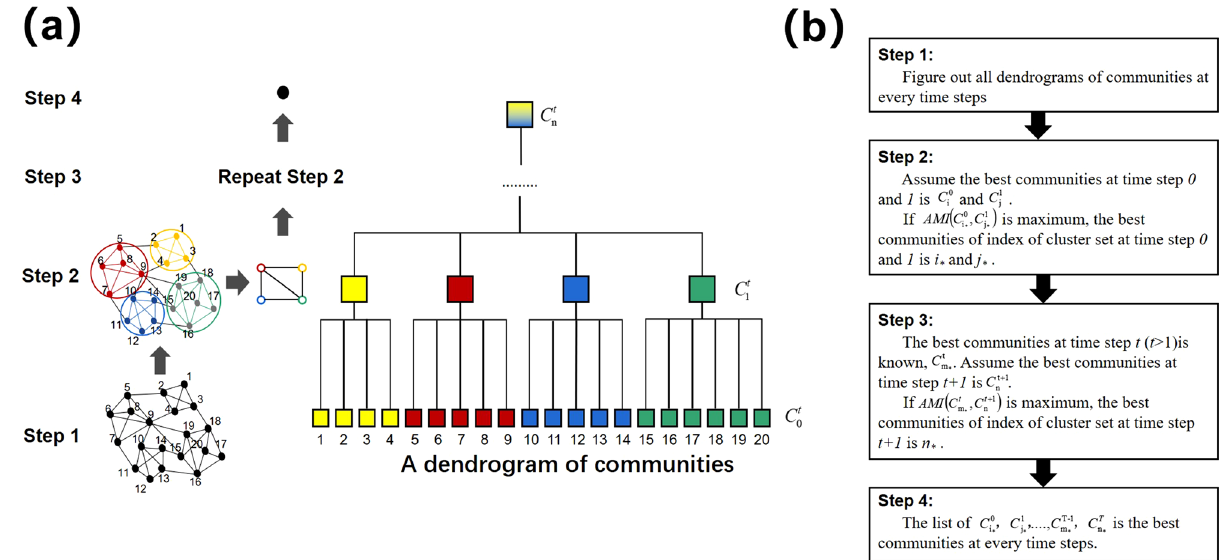
Figure 8. Schematics of the hierarchical clustering method. ( a ) Schematics of the Louvain algorithm. ( b ) Flowchart for the modified